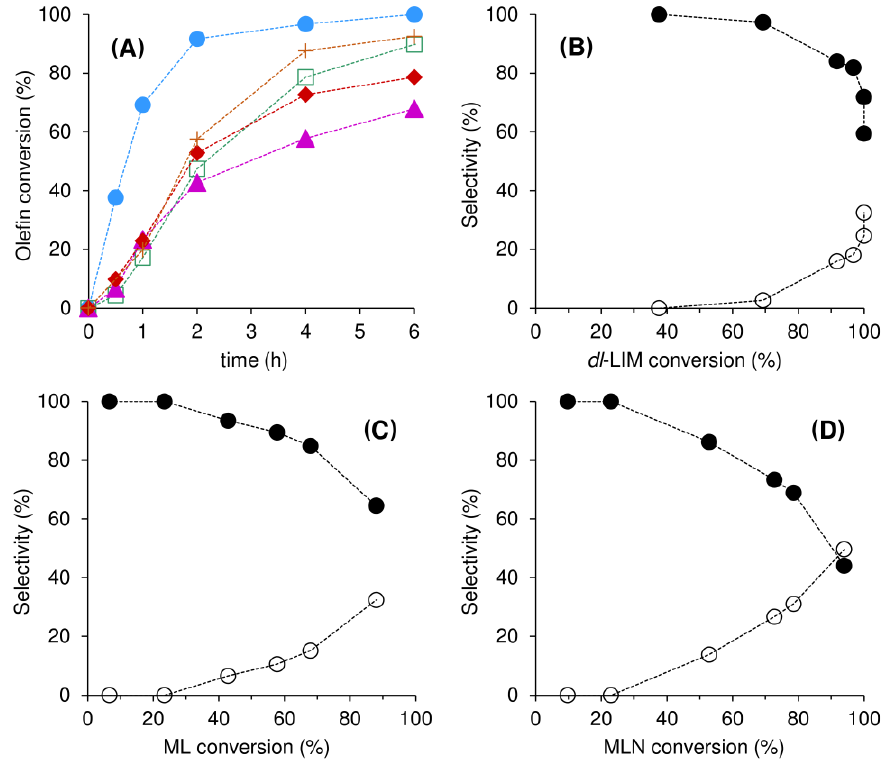
Figure 9. Kinetic profiles for the reaction of dl -limonene ( ● ), methyl oleate ( □ ), methyl linoleate ( ▲ ), methyl linolenate ( ◆ ), and methyl ricinoleate ( + ) with TBHP, in the presence of 2 , at 70 °C ( A ), and selectivity to the monoepoxides ( ● ) and diepoxides ( ○ ) of LIM ( B ), ML ( C ), and MLN ( D ) as a func- tion of olefin conversion. Dashed lines are visual guides. Table 1. Catalytic results for olefin epoxidation at 70 °C and sulfide oxidation at 35 °C, in the pres- ence of 2 using TBHP as oxidant.